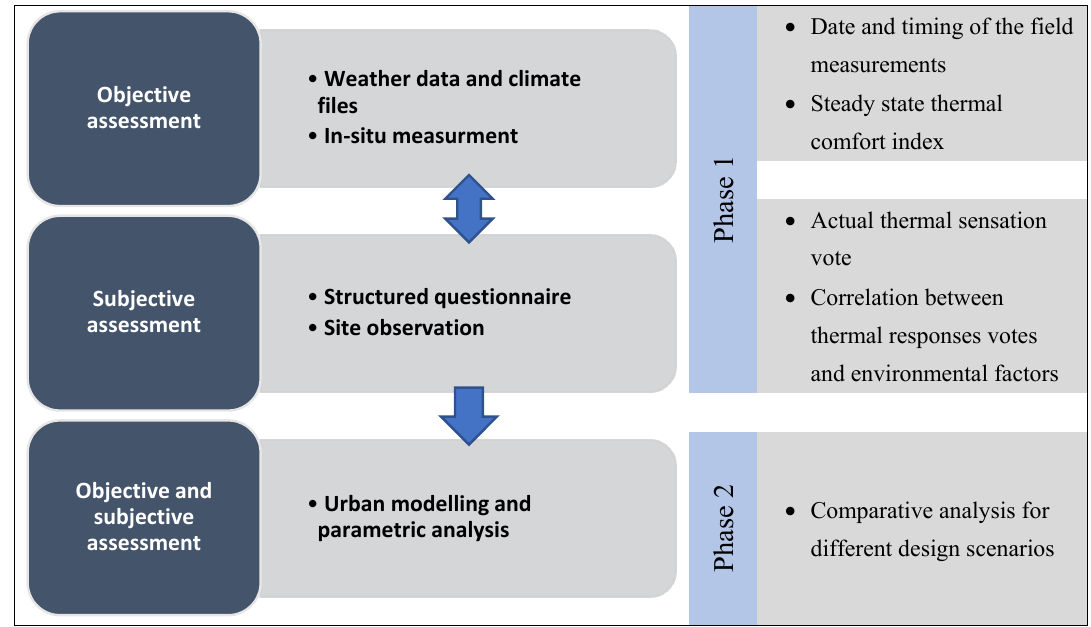
Figure 2. Methodological